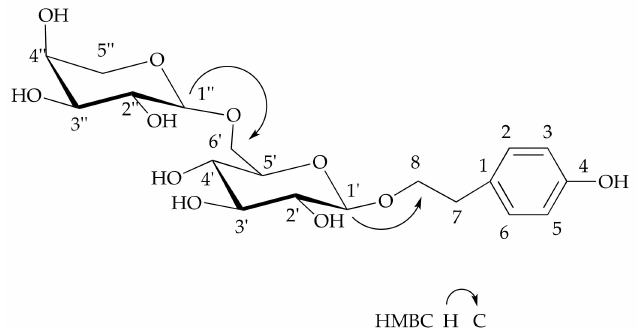
Figure 1. Structure and key HMBC correlations in 4-hydroxyphenyl ethyl-8- O -[ α - l -arabinopyranosyl- (1 → 6)]- β - d